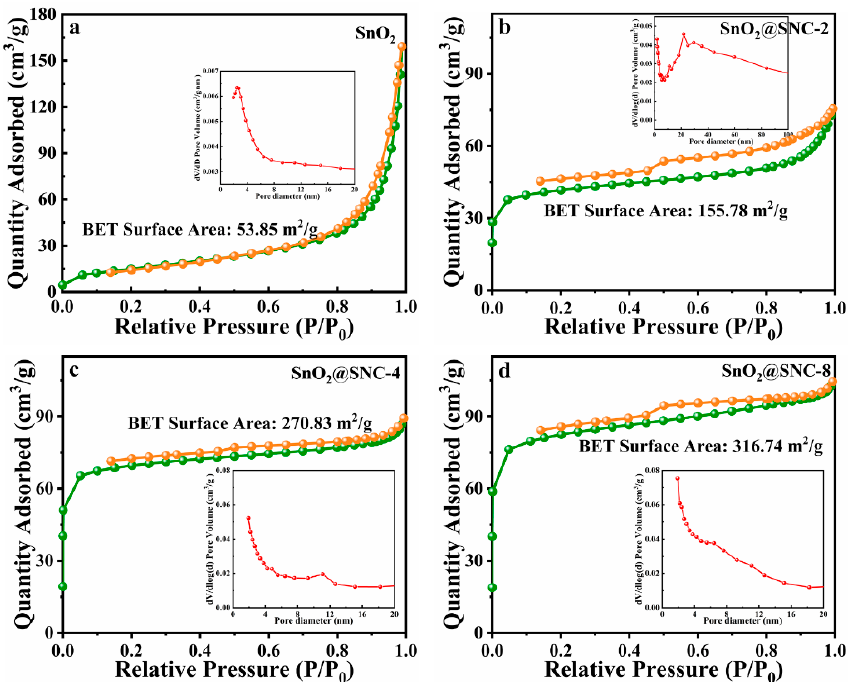
Figure 4. N 2 adsorption-desorption isotherm (the insets showing the pore size distribution) for ( a ) pure SnO 2 , ( b ) SnO 2 @SNC − 2, ( c ) SnO 2 @SNC − 4 and ( d ) SnO 2 @SNC − 8 composite. SnO − 2, ( c ) SnO − 4 and ( d ) SnO − 8 2 , ( b ) SnO 2 @SNC 2 @SNC 2 @SNC